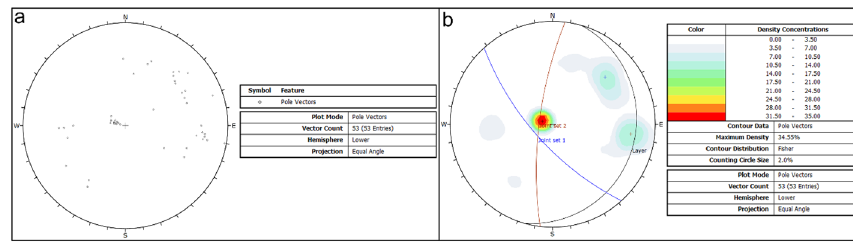
Fig. 8 Pole points ( a ) and contour diagram ( b ) of discontinuity and layer